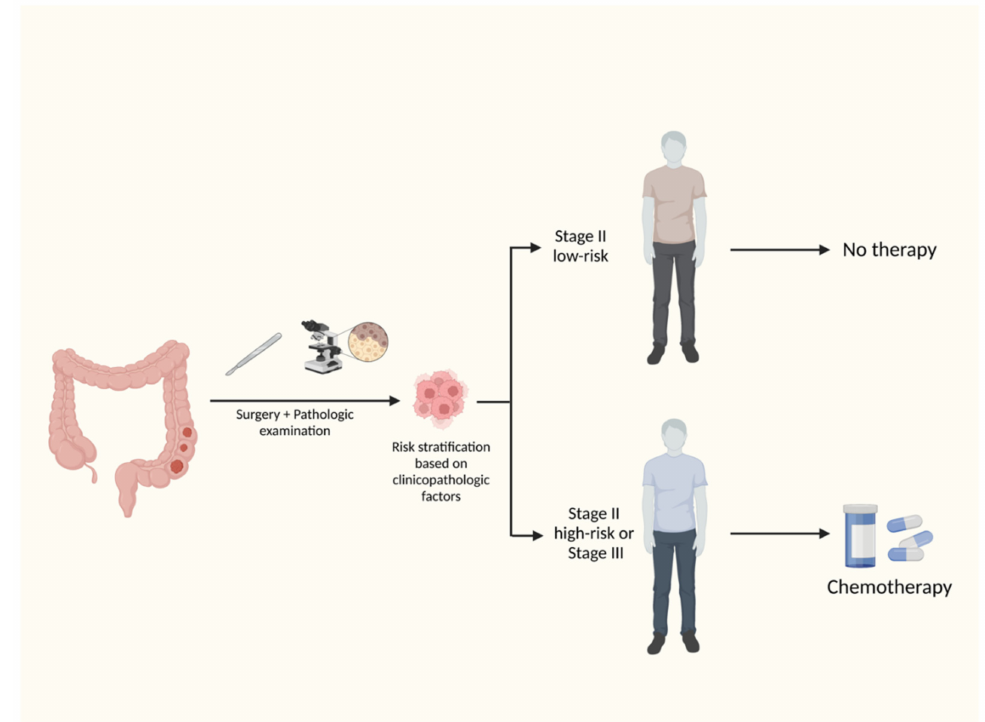
Figure 1. Standard of care of adjuvant therapy of colon cancer. The current selection of patients for adjuvant chemotherapy is based on the presence of prognostic clinicopathologic factors, which offer an inaccurate risk stratification in low-risk and high-risk stage II and stage III colon cancer. Created with